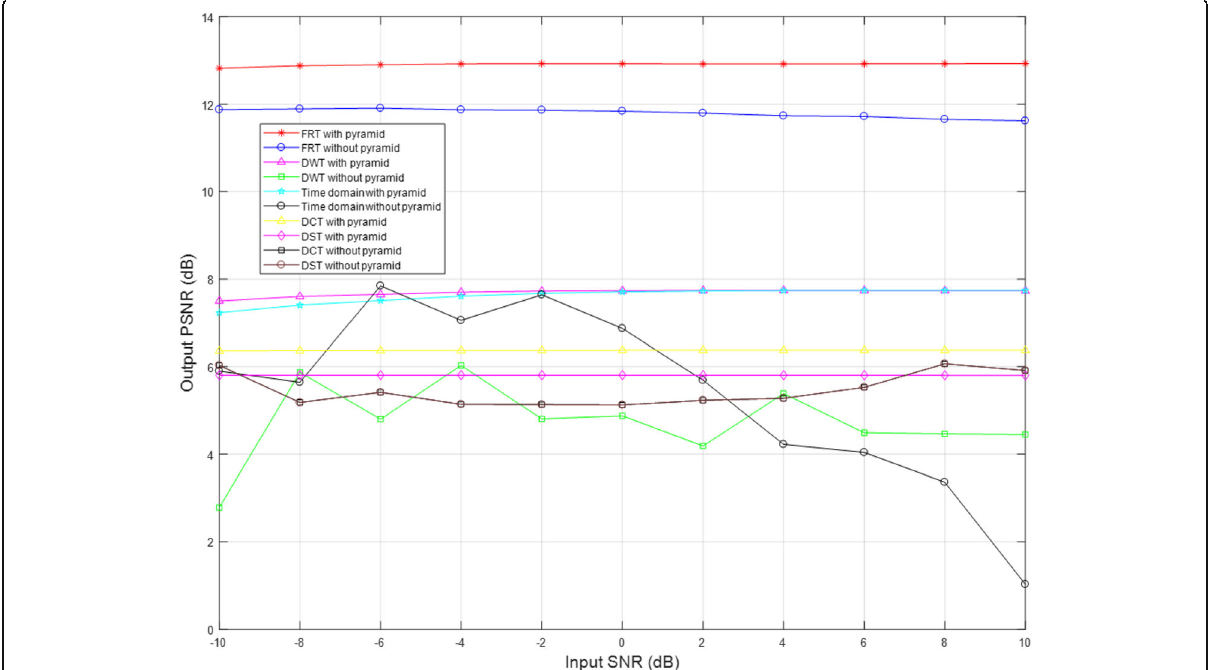
Fig. 13 Output PSNR vs. input SNR for Cameraman image overall separation performances